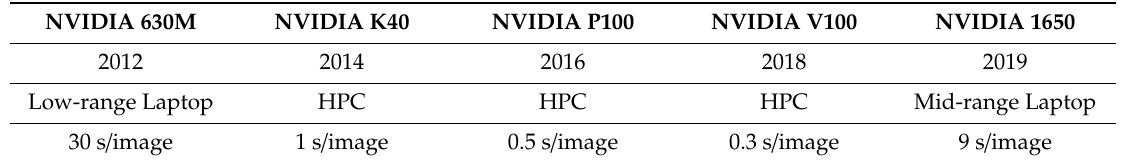
Table 6. Hardware Table 6. Hardware comparison.